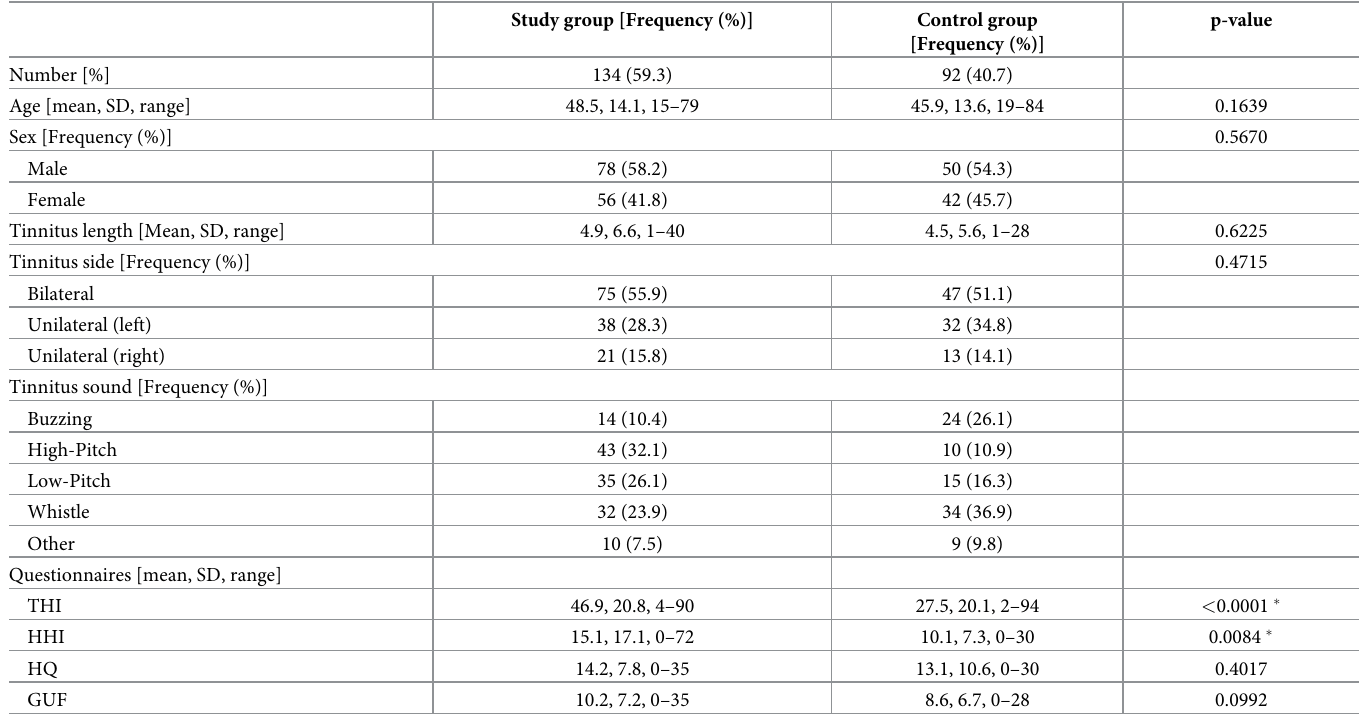
Table 2. Demographic and audiological characteristics of patients in the study and control